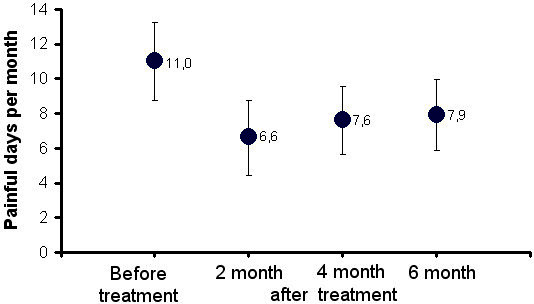
Comparison of the frequency of painful days before and after treatment belonging to the group received injection of lidocaine hydrochloride 5 times. A significant decrease in the frequency of painful days after treatment (2, 4 and 6 month) compared to pre-treatment was observed P < 0.001). 2., 4. and 6. Months after the treatment, there was no difference between the frequency of painful days (P > 0.005).